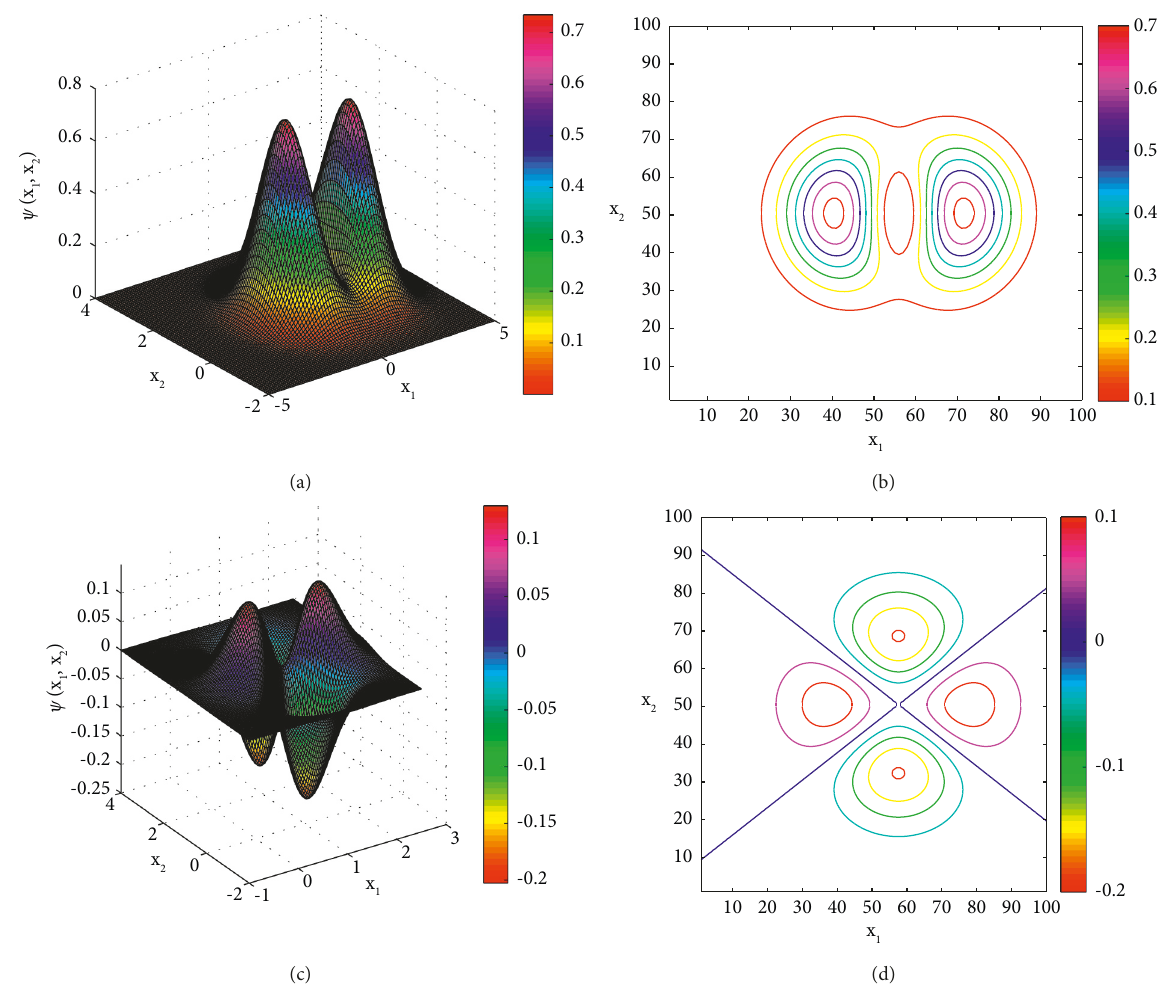
( x ,x ) given by equation (34) at different values of a, r ,b , and s . (a) 2D-shearlets at a,s,b 1 2